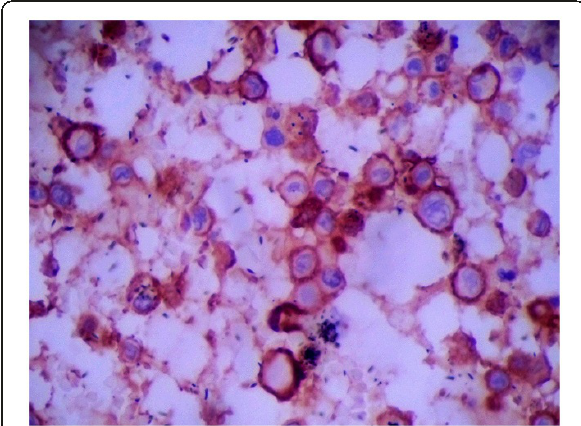
Figure 5 LCS tumor cells expressed CD1a